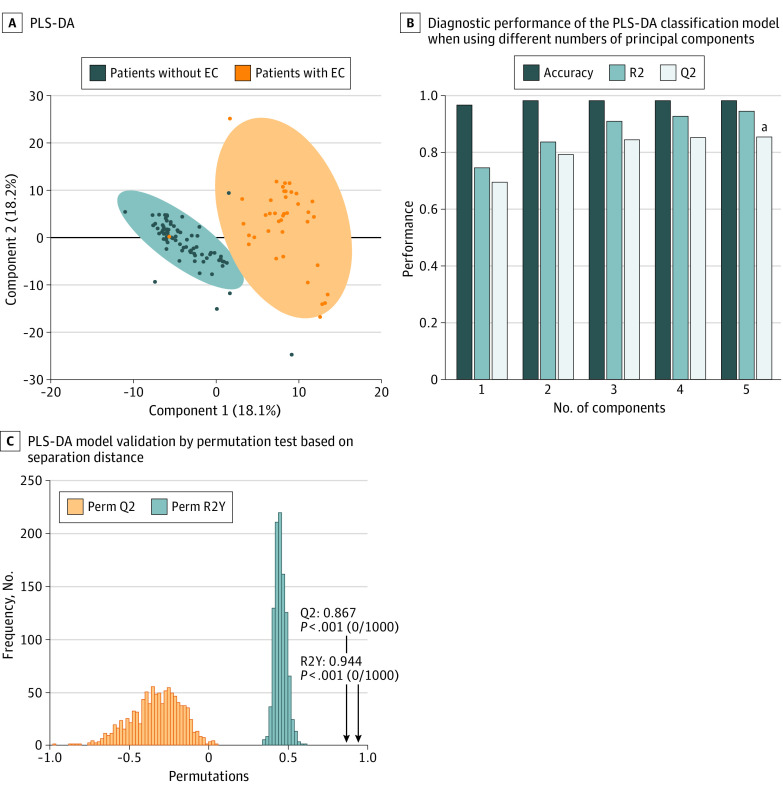
Partial Least Square–Discriminant Analysis (PLS-DA) ModelA, The figure illustrates separation between the training set data, indicating that the measured metabolomic profiles of patients with vs without endometrial carcinoma (EC). B, The best performance (denoted with a) was achieved when using 5 principal components as the basis for classification. C, PLS-DA model validation by permutation test based on separation distance. Perm indicates permutation-based.